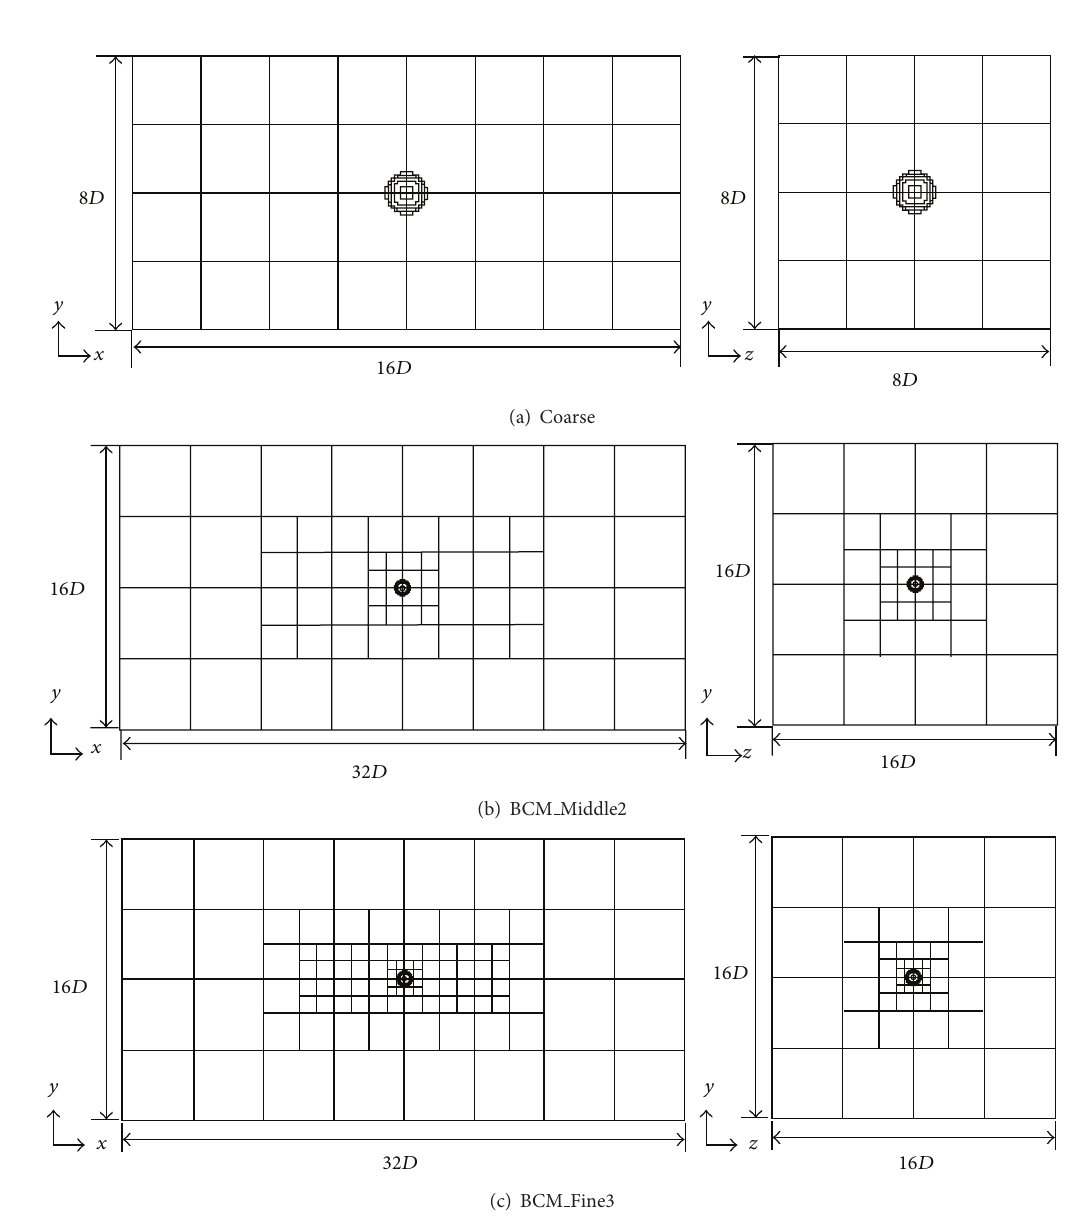
Figure 7: Computational domains and cube boundaries for acoustic scattering around a sphere of diameter D